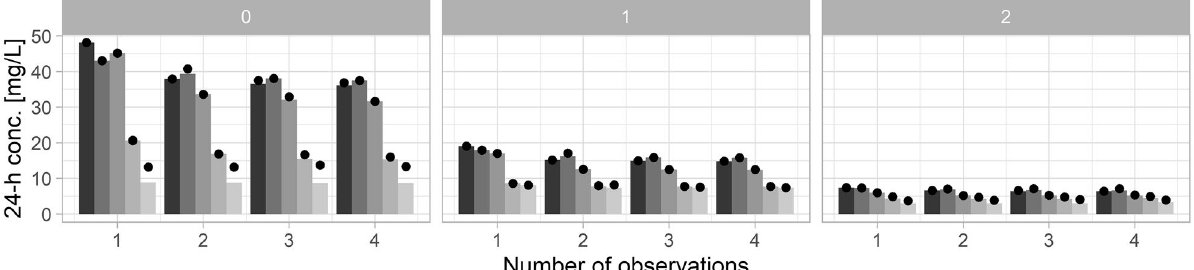
Figure 5. RMSE concerning predicted versus observed iohexol concentrations 1440 min post injection stratified by eGFR quartiles. Different shades of gray represent the full two-compartment, reduced two- compartment, full three-compartment, reduced three-compartment, and the reduced three-compartment model with covariates (from left to right/black to light gray). Patients with low (0), intermediate (1), high (2) eGFR as defined by quartiles (< 25%, corresponding to < 23 mL/min; 25–75%, 23 to 34 mL/min; > 75%, > 34 mL/ min). Bars indicate RMSE for optimal sampling times stratified by eGFR while dots represent RMSE in the respective eGFR group when a single sampling protocol is used for all